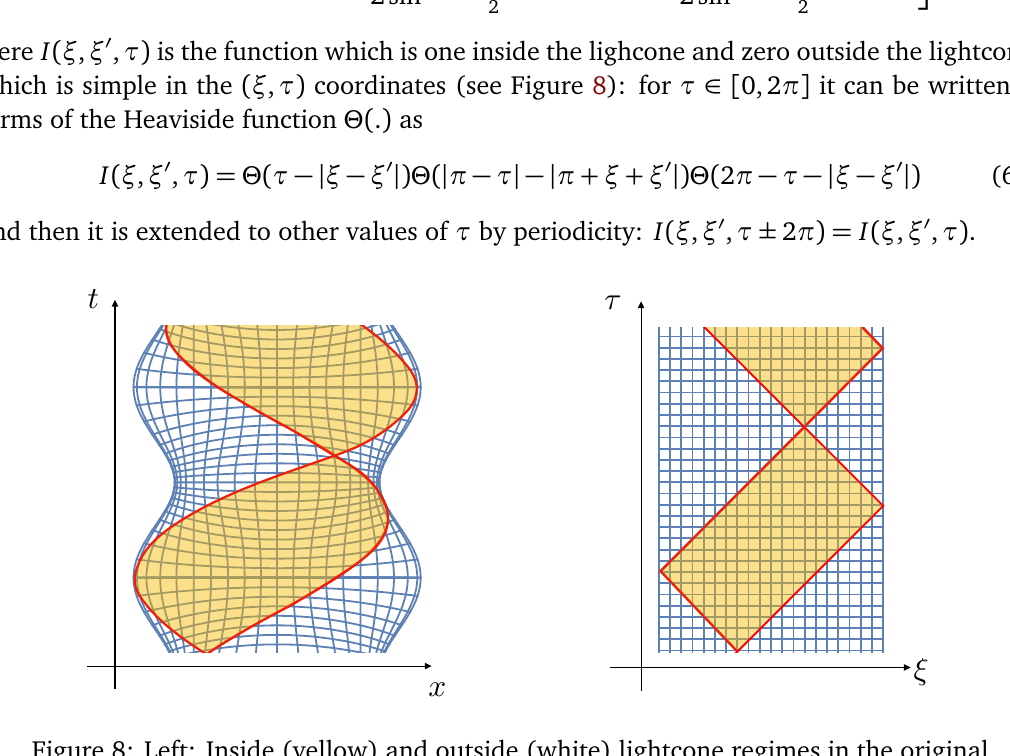
Figure 8: Left: Inside (yellow) and outside (white) lightcone regimes in the original ( x , t ) coordinates. The continuous red line represents the lightcone. Right: Same in the ( ξ , τ ) coordinates. The grid shows the boundary of the